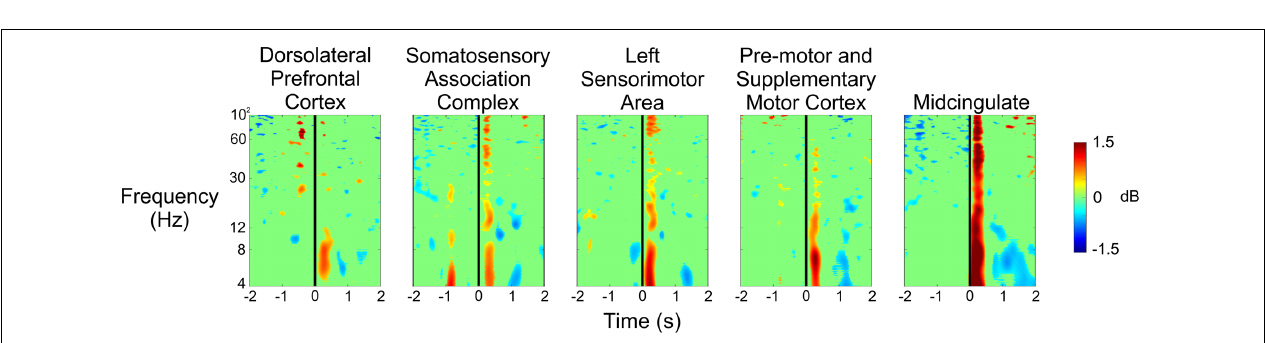
FIGURE 5 | (A) Event-related spectral perturbation plots for (from top to bottom) the Stress condition, the Control condition, and the difference of the two for all five independent components (columns). The vertical black line indicates the time the subject pulled the trigger. (B) Spectral power of each of the five independent components in the Stress (red) and Control (blue) conditions. Blue vertical lines at the bottom of each plot indicate that the Control condition had significantly greater power in that region; red lines indicate that the Stress condition had significantly greater power ( p < 0.05).